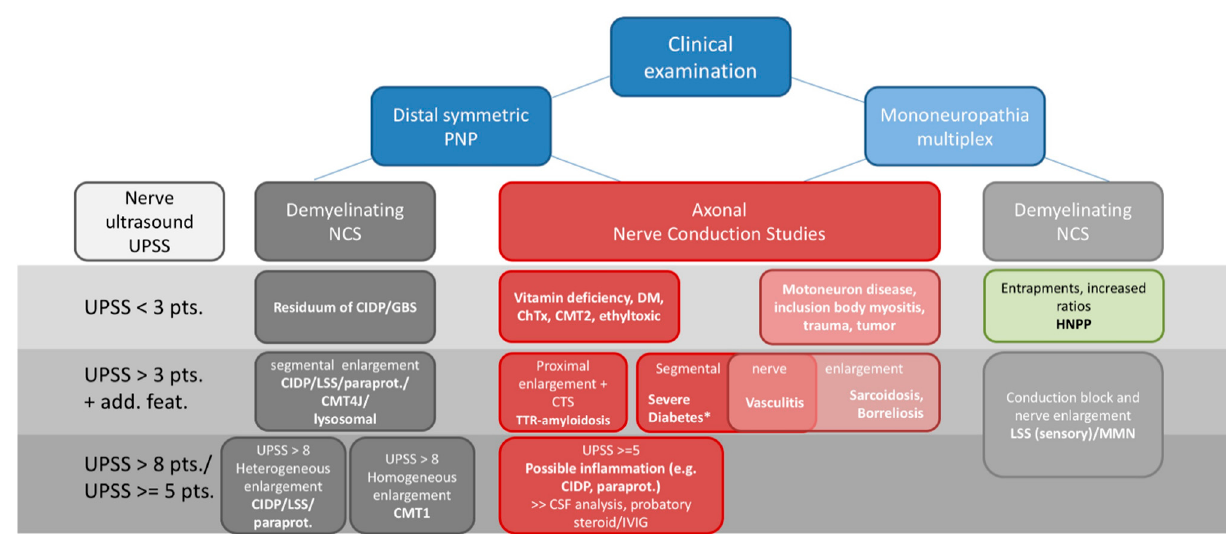
Figure 6. Proposed diagnostic algorithm and possible, most common differential diagnosis for clinical routine including clinical examination, nerve conduction studies and nerve ultrasound. * an additional inflammatory component might play a role in nerve enlargement. Abbreviations: ChTx = chemotherapy, CIDP = chronic inflammatory demyelinating polyneuropathy, CMT = Charcot Marie Tooth, CSF = cerebrospinal fluid analysis, CTS = carpal tunnel syndrome, DM = diabetes mellitus, HNPP = hereditary neuropathy with pressure palsies, GBS = Guillain-Barre-Syndrome, IVIG = intravenous immunoglobulin, LSS = Lewis-Sumner Syndrome, MMN = multifocal motor neuropathy, NCS = nerve conduction studies, paraprot. = paraproteinemic polyneuropathies, PNP = polyneuropathies, TTR = hereditary transthyretin related amyloidosis, UPSS = ultrasound pattern sum score.